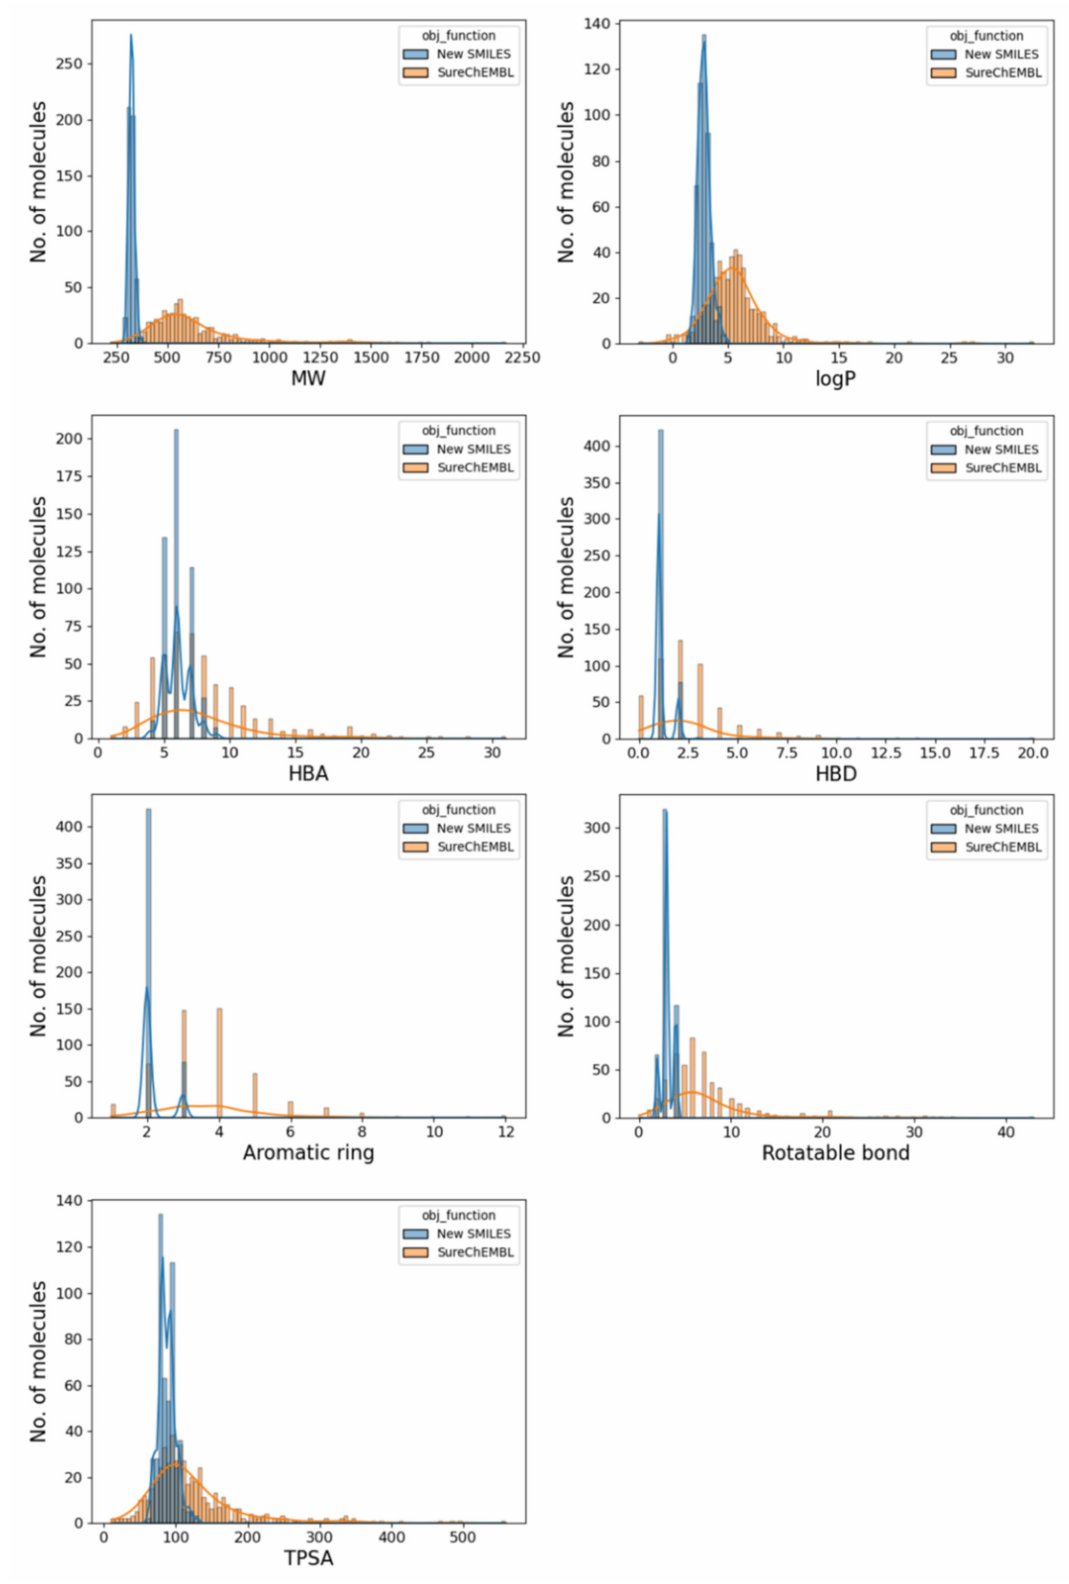
Figure 7. Properties of the 500 molecules produced (molecular weight, log P , number of H-bond donor-acceptors, number of aromatic rings, number of rotatable bonds, and total polar surface area) compared to the corresponding properties of the 500 molecules from SreChEMBL with the highest